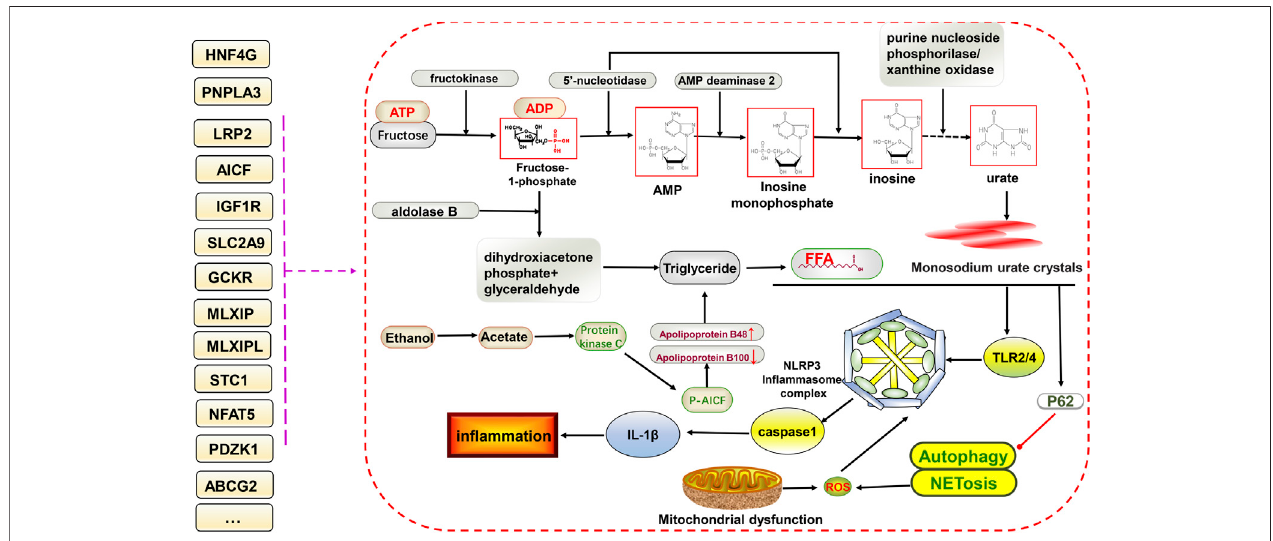
FIGURE2| Potentialrelationshipbetweengenevariants andglucolipidmetabolismandNLRP3in fl ammasome-mediated in fl ammatorypathwaysinhyperuricemia and gout. The ingestion of fructose increases uric acid formation via the gluconeogenic pathway. In addition, triglycerides are also produced, increasing free fatty acid contents via thelipid metabolic pathway. Free fatty acids and monosodium urate crystals together stimulate downstreamTLR2/4and NLRP3 in fl ammasome formation, facilitatetheofreleaseIL-1 β ,andinhibitP62-mediatedactivationofautophagyandNETosis,ultimatelypromotingin fl ammation.Genevariantshavedifferenteffects on different